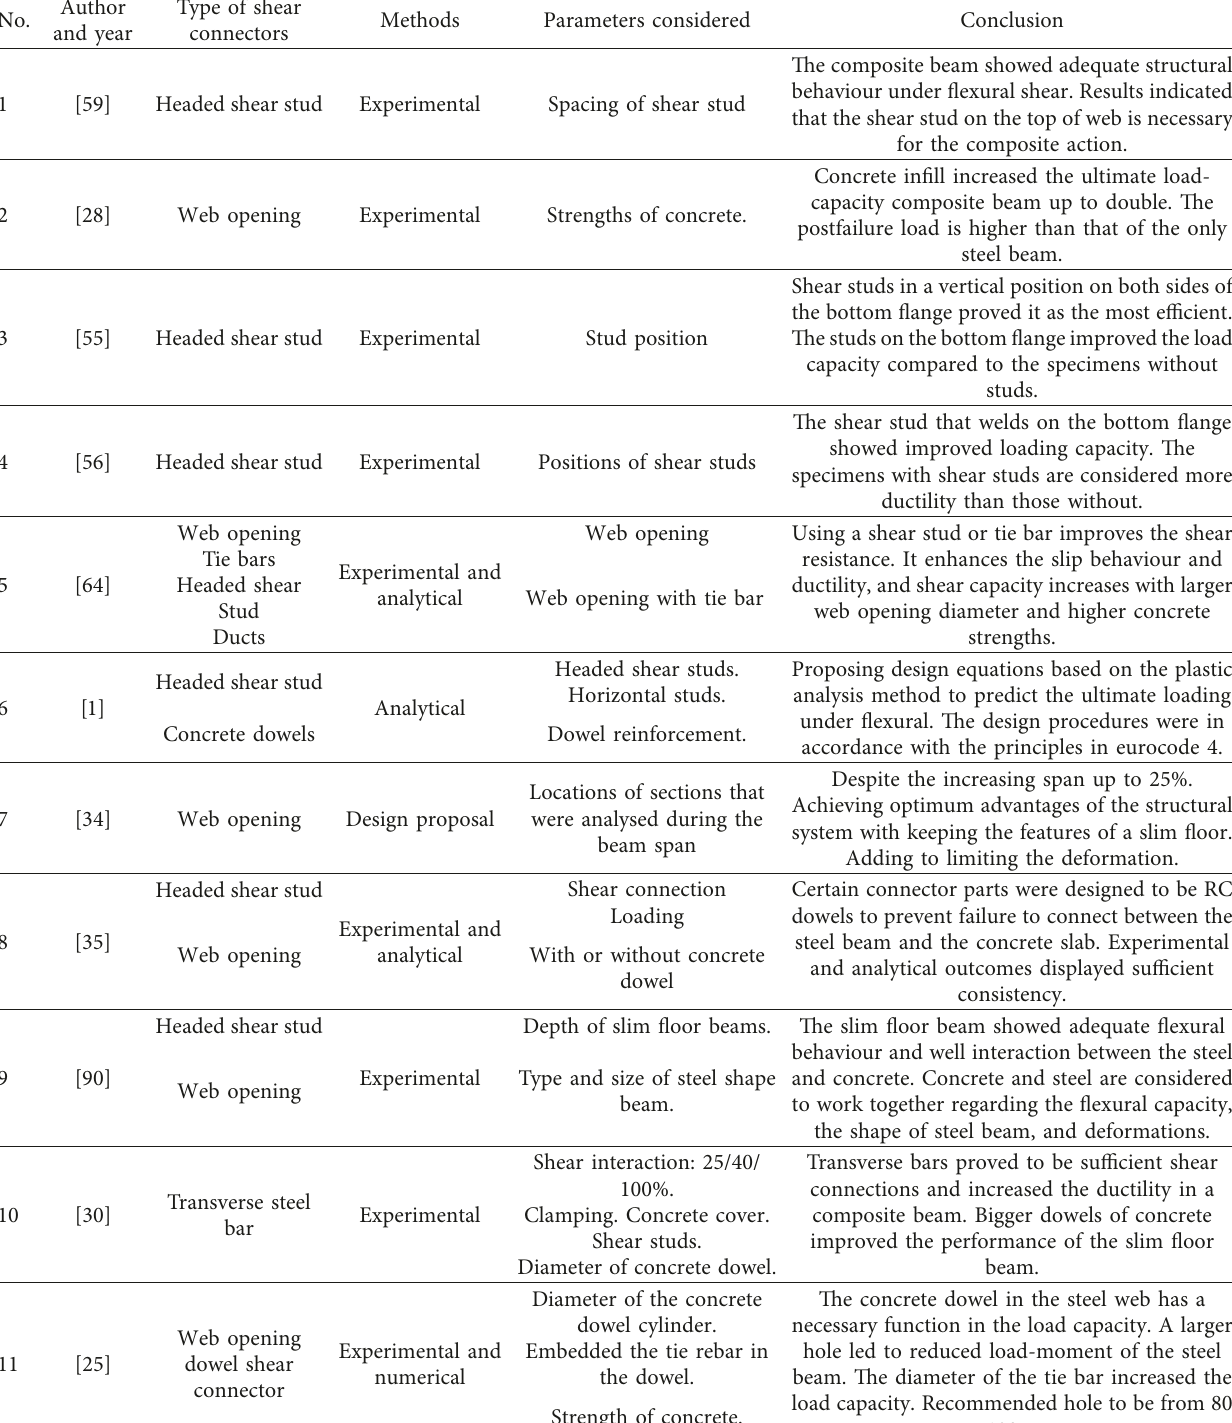
Table 3: Summary of studies on shear connectors in slim floor construction conducted using flexural